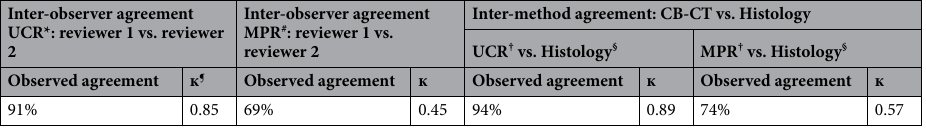
Table 1. Scalar translocation event evaluation after cochlear implantation (n = 32) ⁑ . ⁑ scalar translocation event: minimal of one electrode-contact in scala vestibuli or scala media, including direct scala vestibuli insertions; *UCR uncoiled cochlear reconstruction CB-CT images; # MPR axial and sagittal multiplanar reconstructions; † if observations by reviewer 1 and 2 were different, consensus was achieved by final decision of reviewer 3; § based on observations of reviewer 3; ¶ magnitude of kappa coefficient: < 0: poor, 0.00–0.20 = slight, 0.21–0.40 = fair, 0.41–0.60 = substantial, 0.81–1.00 = excellent agreement.